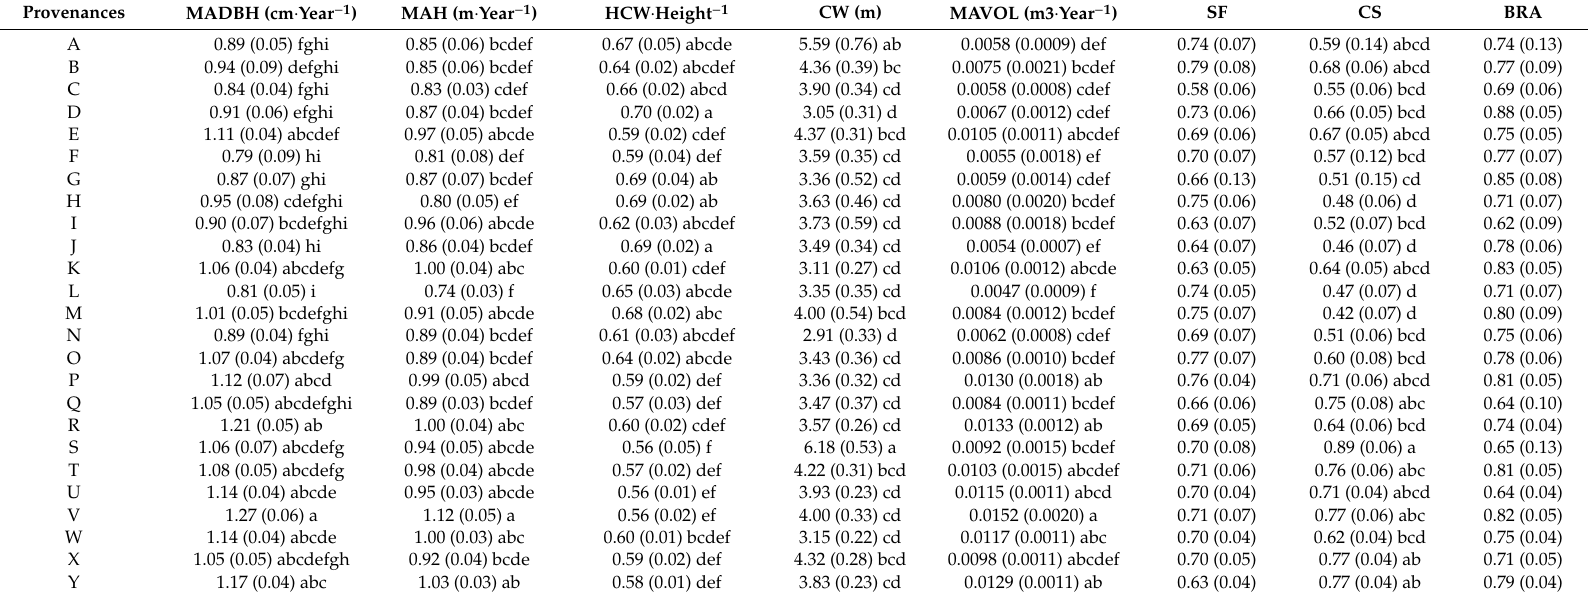
Table A3. Growth and quality traits for 25 provenances of Betula alnoids at Pingxiang